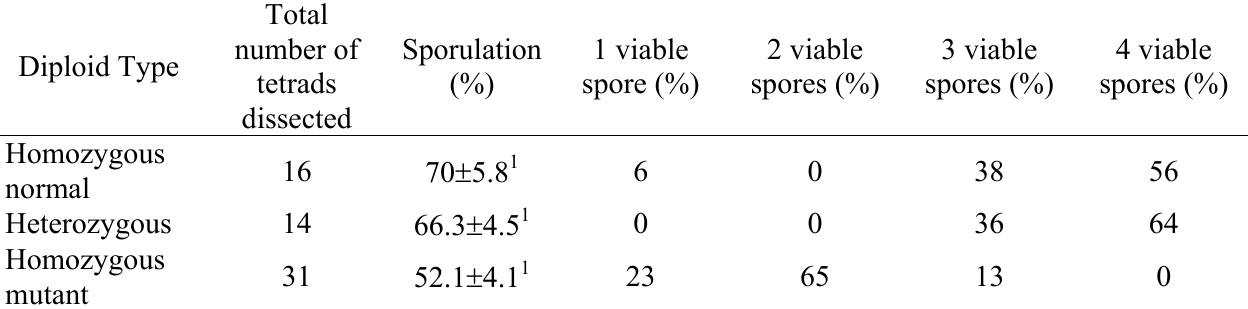
Table 2b. Percentage of viable spores produced by each